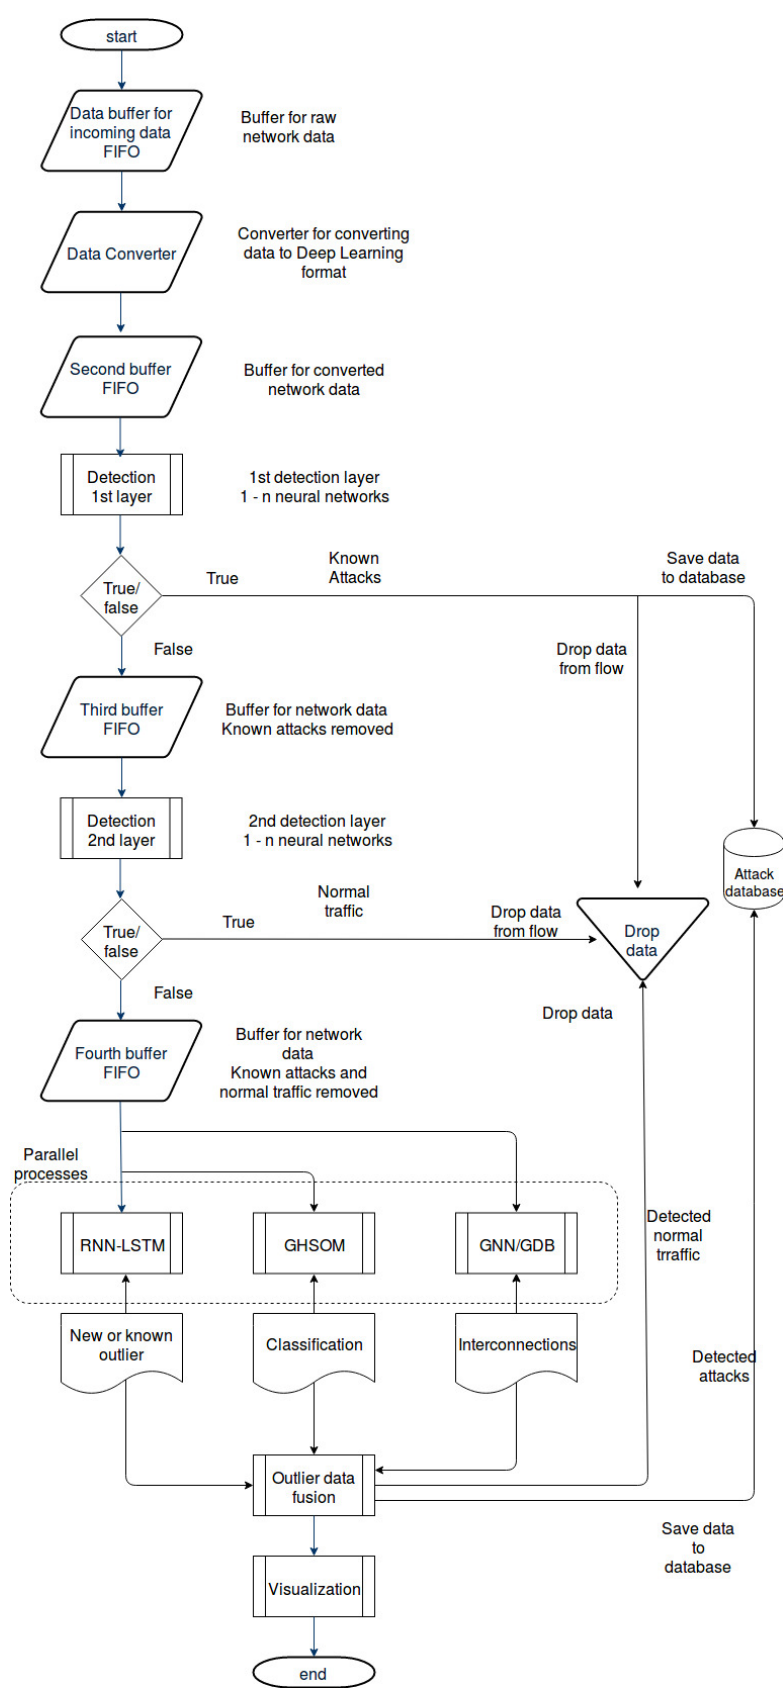
Figure 1. Data flow through the detection